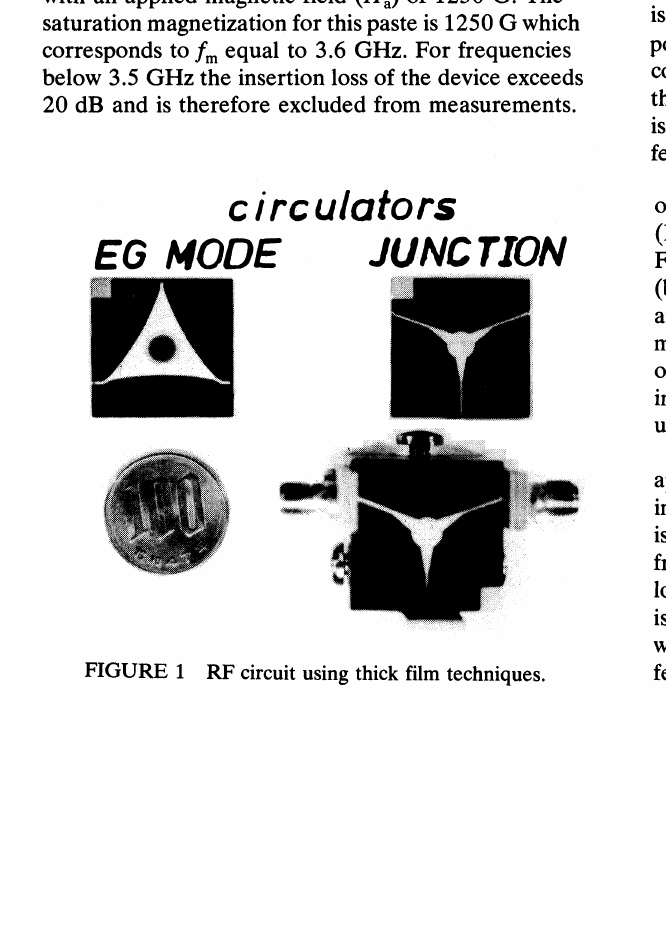
RF circuit using thick film techniques.